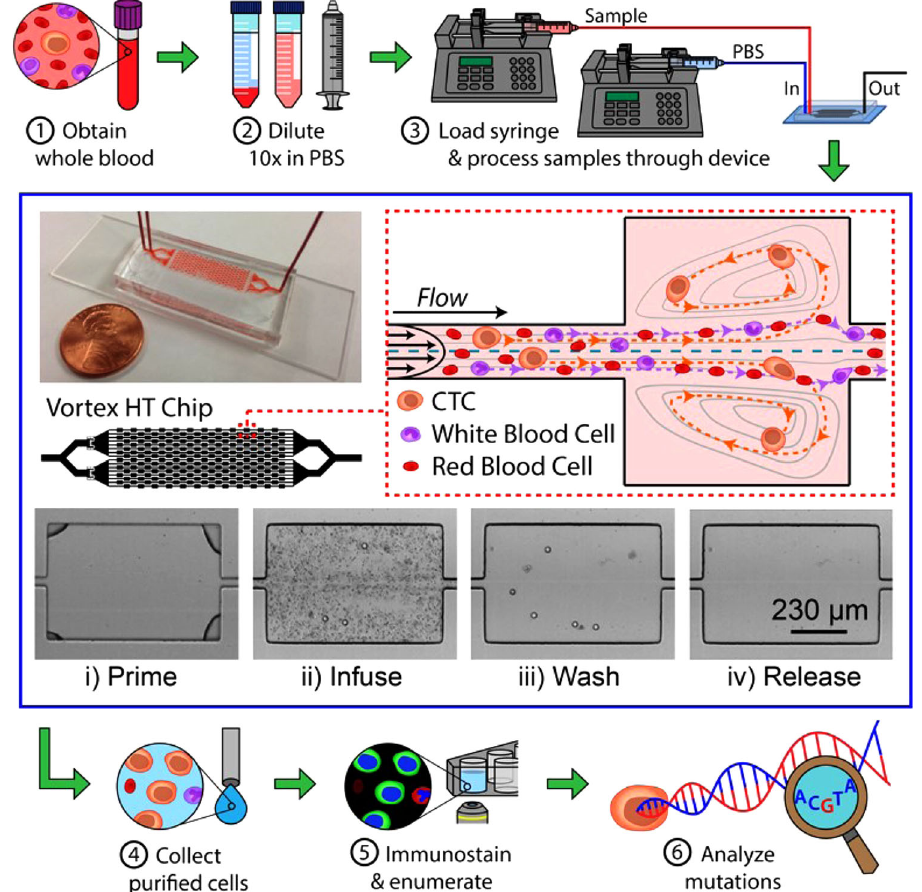
Fig. 1 Sample processing work fl ow with the micro fl uidic Vortex HT chip. ① Whole blood samples are collected from donors in EDTA-coated tubes. ② Blood is diluted 10-fold in PBS before ③ processing through the Vortex HT micro fl uidic device. ④ Puri fi ed CTCs are released in a small volume and collected in a 96-well plate. ⑤ Cells are fi xed, immunostained, and imaged before manual enumeration. ⑥ Mutation analysis is performed using a targeted NGS panel. The Vortex HT chip consists of 16 parallel channels and 12 serial reservoirs in each channel ( blue box ). At high fl ow rates (8 mL/min), laminar microvortices develop in the rectangular reservoirs and trap larger cancer cells, while smaller blood cells (RBCs and WBCs) either pass through ( red dotted box ) or are not stably trapped during the wash step. Sample processing involves (i) priming the device with wash solution to remove air bubbles, (ii) infusing the sample and capturing target cells, (iii) switching to a wash solution at the same fl ow rate, and (iv) releasing captured cells by lowering the fl ow rate to dissipate the